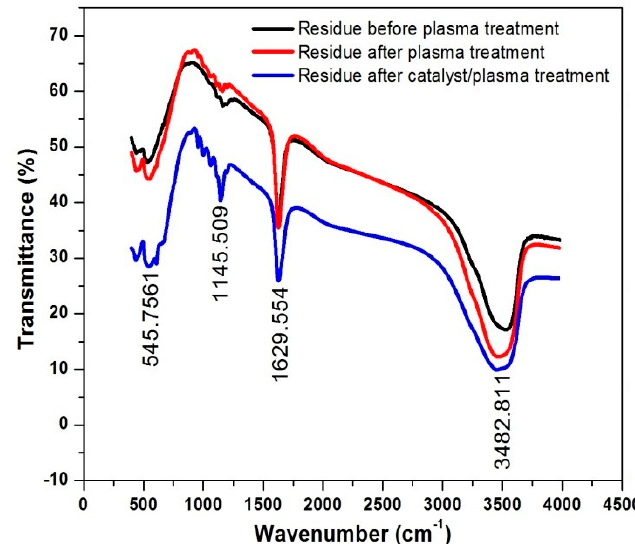
Figure 10. FT-IR patterns of the solid residue of untreated and plasma-treated industrial wastewater.